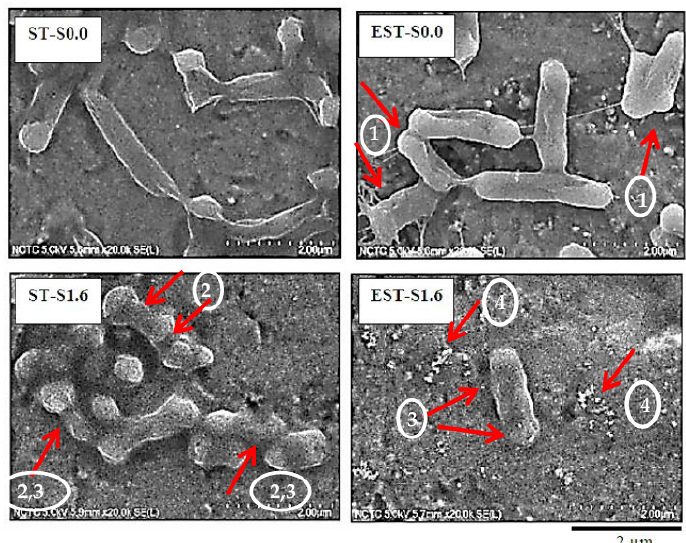
Figure 3. Morphology of E. coli ATCC 25922 cells of biofilm-contaminated titanium surface with non-ionic and non-electrical treatment (ST-S0.0) in comparison to those with electrical treatment (EST-S0.0), ionic silver 1.6 µg/mL without electrical treatment (ST-S1.6), and ionic silver 1.6 µg/mL with electrical treatment (EST-S1.6).